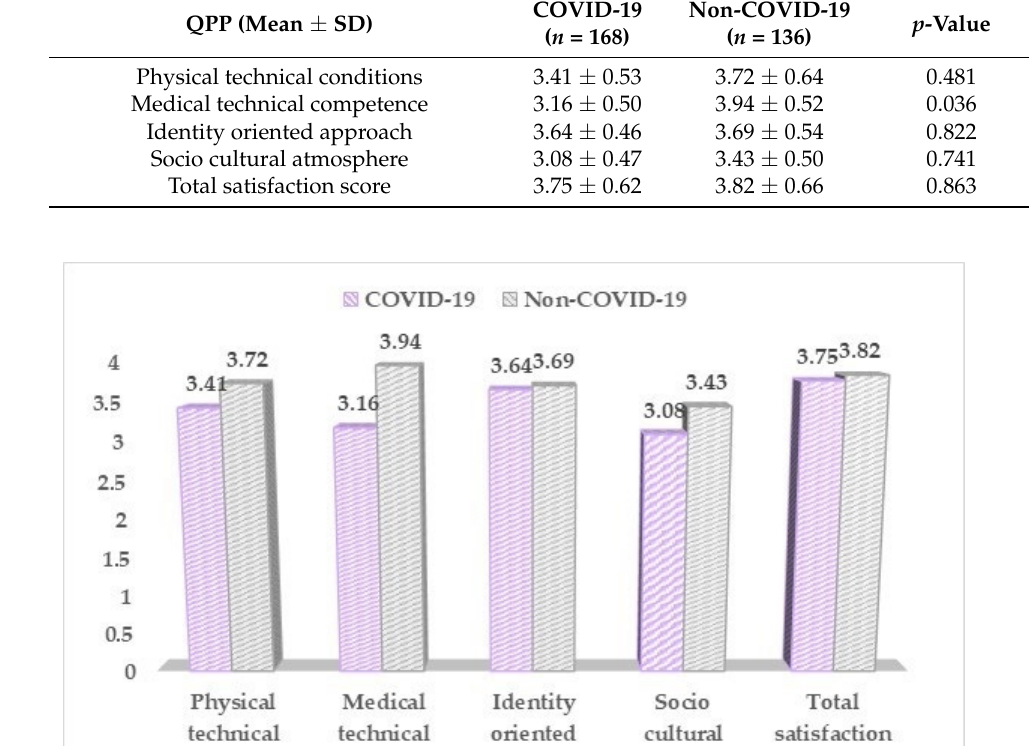
Table 6. The QPP questionnaire results between COVID-19 positive and negative pregnant women.